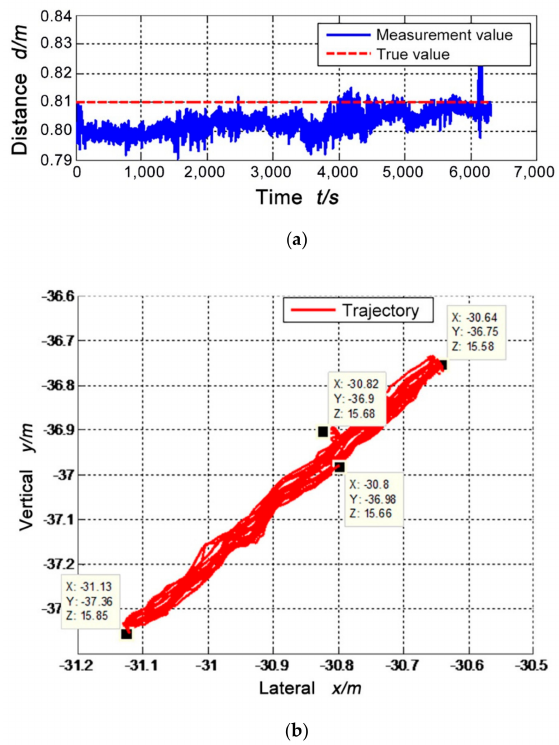
Figure 16. Measurement results of static and dynamic positioning data between A and B. ( a ) Static distance measurement value and measurement error between A and B. ( b ) Three-dimensional trajectory measurement of back and forth movement between A and